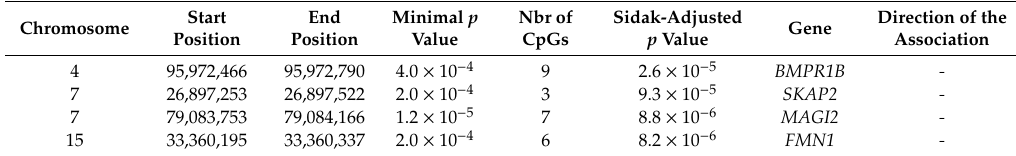
Table 3. Regional placental DNA methylation associated to early-childhood adiposity. Start End Minimal p Chromosome Position Position